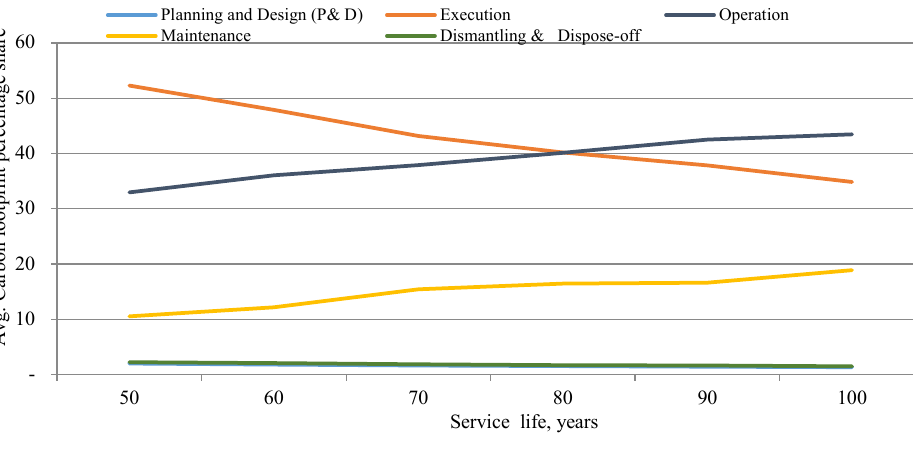
Fig.7. Phase wise variations in average contribution